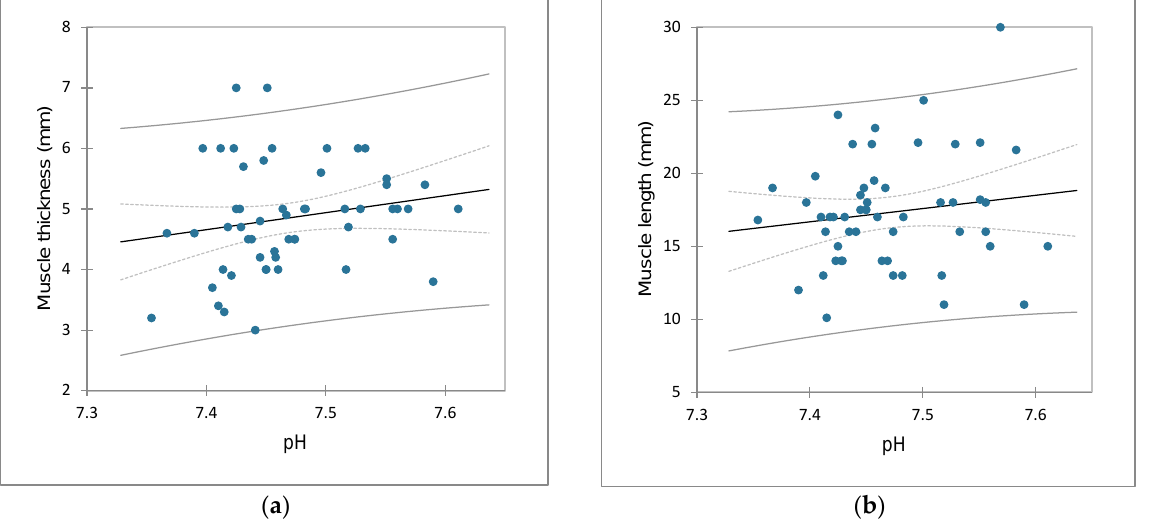
Figure 1. Scatterplots: ( a ) correlation of muscle thickness and pH; ( b ) correlation of muscle length and pH.